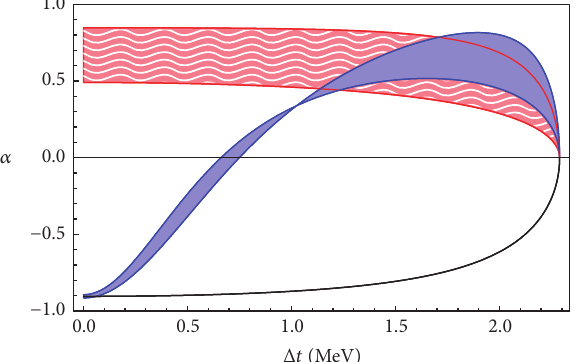
Figure 8: The angular correlation coefficient for 124 Sn. The red band corresponds to 𝜂 mechanism and the blue band corresponds to 𝜆 mechanism. The width of the bands represents the uncertainties arising from the unknown CP phases 𝜙 1 and 𝜙 2 .